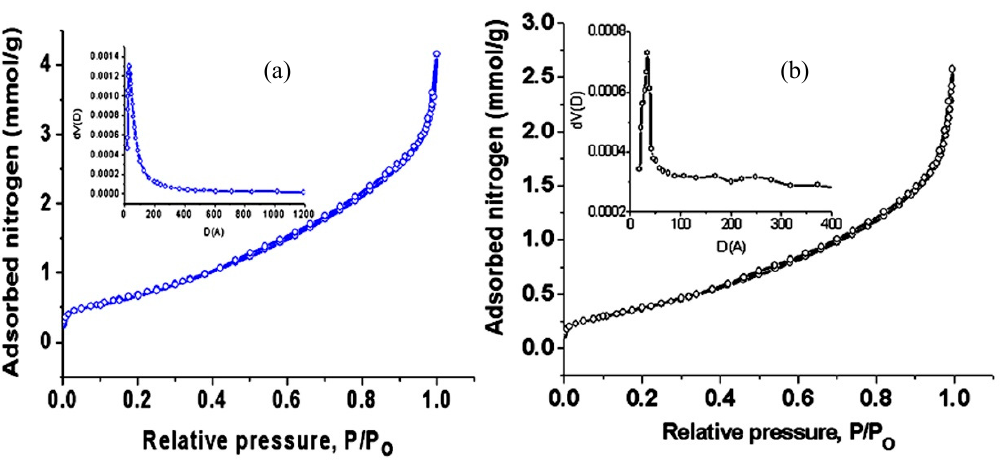
Figure 8. Nitrogen adsorption-desorption isotherm of: ( a ) Zn-Al LDH and ( b ) Zn-Al-GO1 (Inset-Pore size distribution of Zn-Al-GO1).